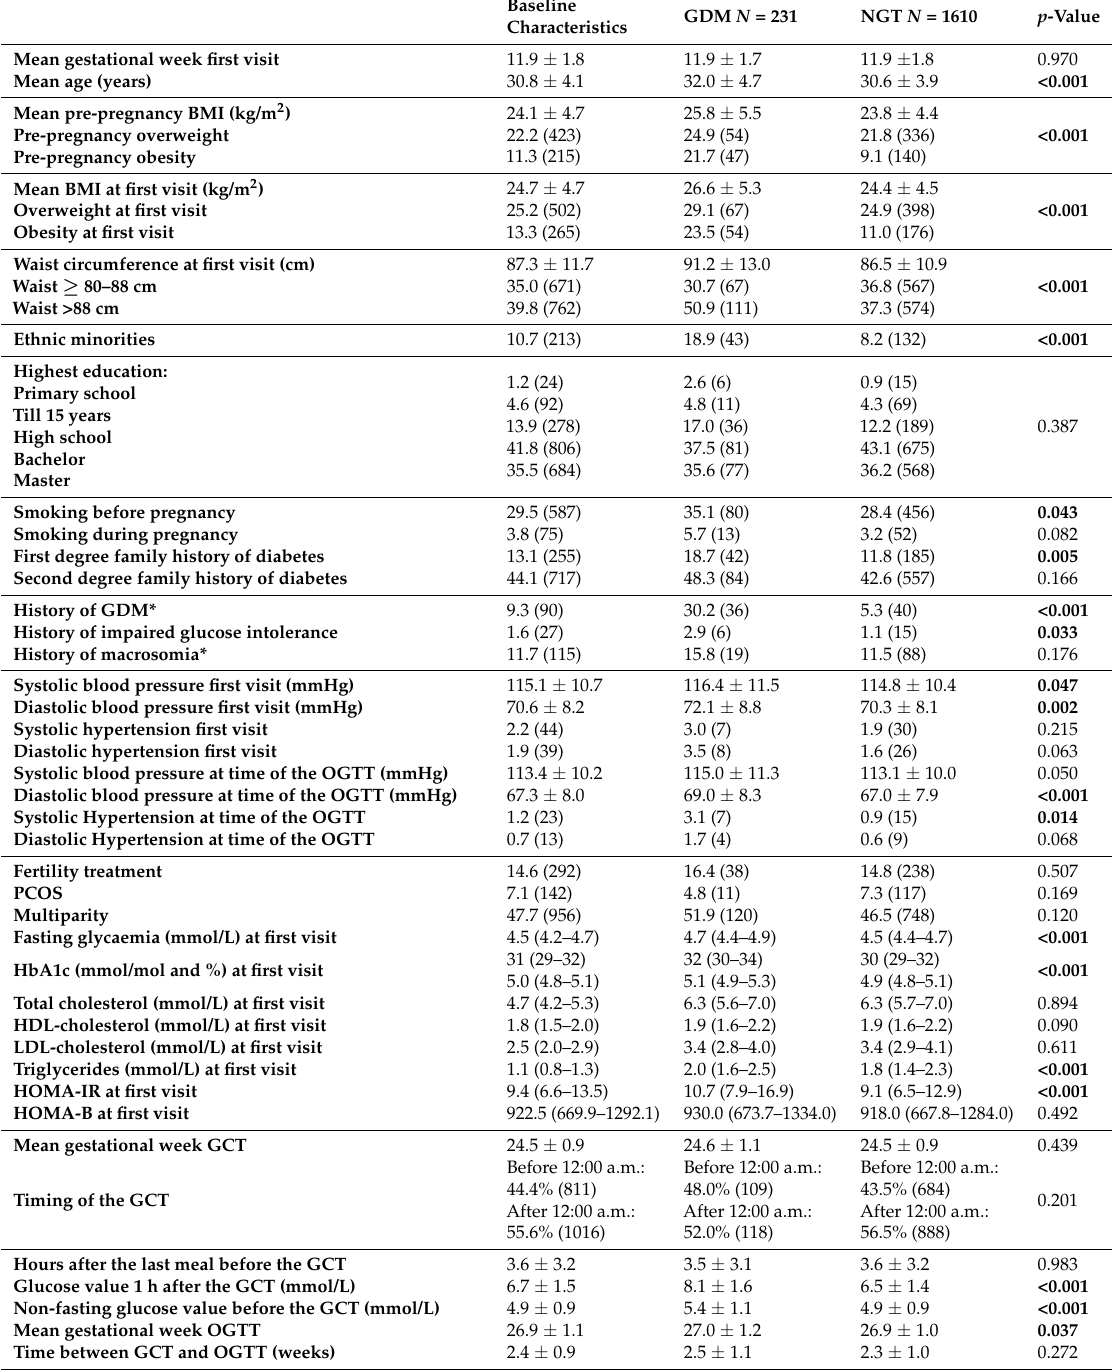
Table 1. The baseline characteristics and comparison of characteristics between the GDM and NGT